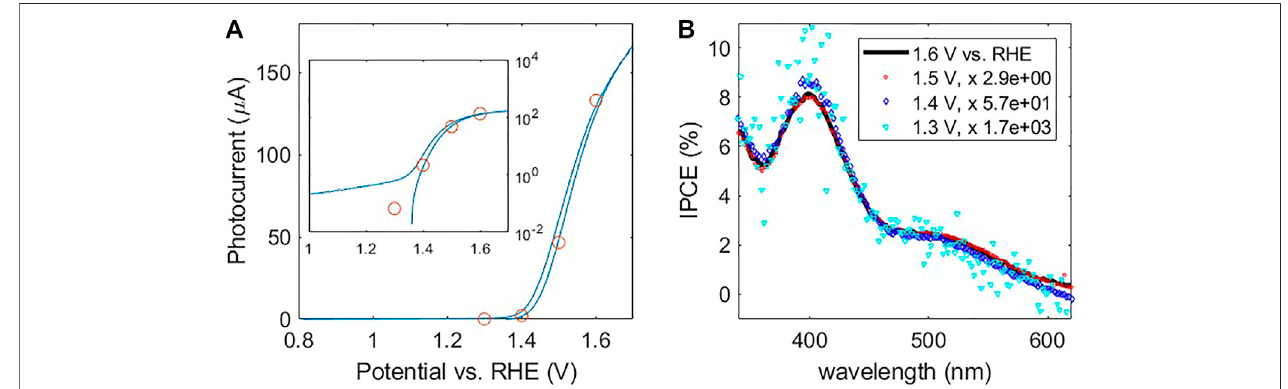
FIGURE 7 | IPCE measurements at different applied potentials along the J ph -U curve of a 1% Sn-doped 7 nm hematite fi lm deposited on ITO-coated glass substrate (A) J ph -U curve, with circles indicating the applied potentials at which IPCE measurements were made and their corresponding integrations with the LED spectrum according to Eq. 3b . The inset plots the same, but with the photocurrent axis on a log scale. (B) IPCE spectra measured at the different applied potentials, in white light bias shown in the legend. The measured spectra were scaled up by multiplying by the factors indicated in the legend. Adapted from Supplementary Figure S4 of (Grave et al.,